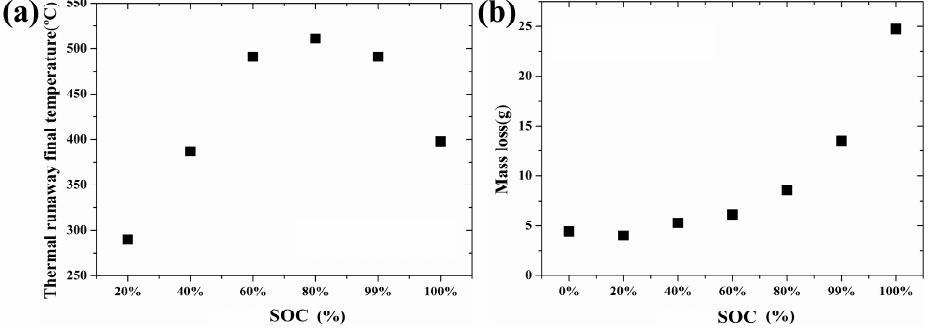
Figure 5. Relationship between SOC and thermal runaway final temperature/mass loss: ( a ) Thermal runaway final temperature; ( b ) Mass loss.